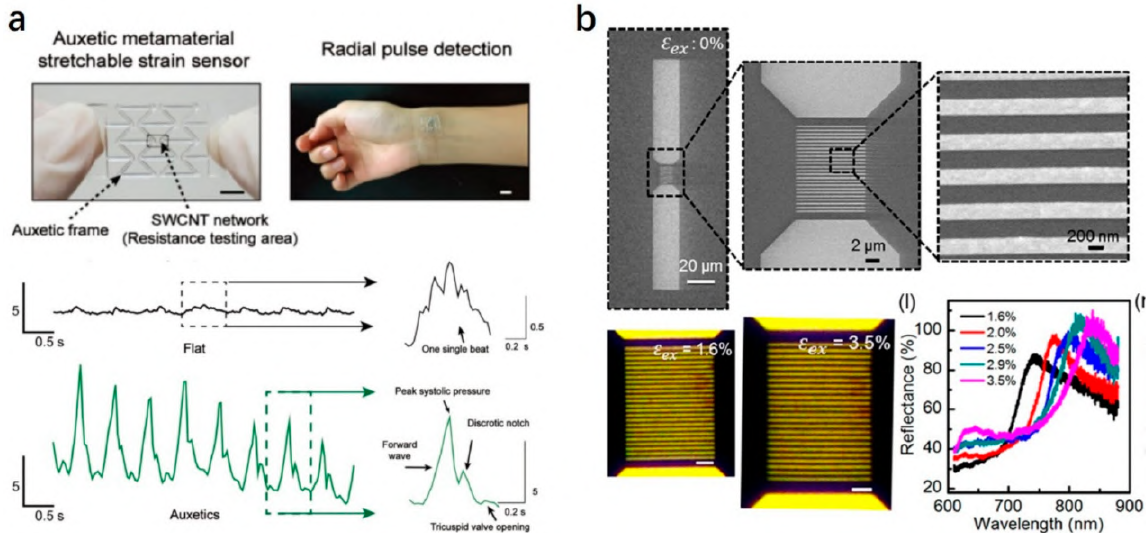
Figure 5. Mechanical metamaterials for sensing. ( a ) Photograph of the auxetic metamaterial stretchable mechanical sensor for radial pulse detection, the detected human pulse profiles by a conventional flat sensor and the metamaterial sensor. Reproduced with permission from [106]. Copyright 2018, Wiley. ( b ) SEM images of the mechanical metasurface on a PDMS substrate without external strain, optical microscope images of the metasurface under 1.6% and 3.5% strain, experimental reflectance of the metasurface with various strains. Reproduced with permission from [77]. Copyright 2018, American Chemical